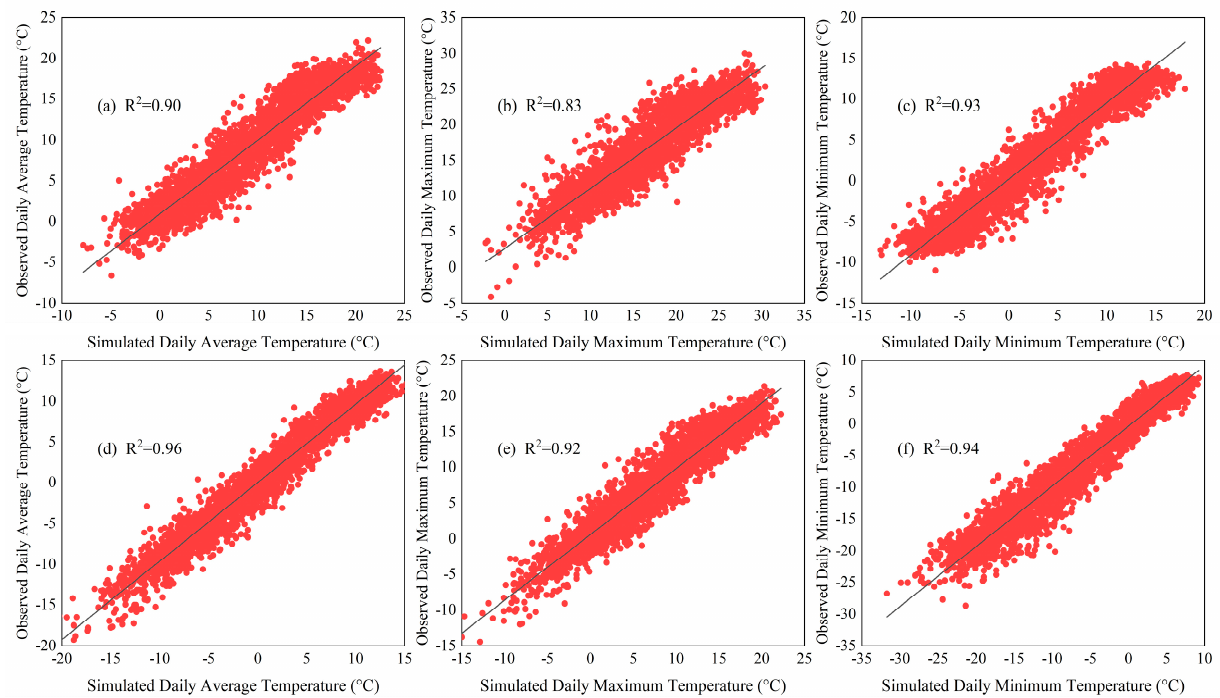
Figure 11. The scatter plots between measured and simulated daily average, maximum, and mini- mum temperature of LASHA station ( a – c ) and NAGQU station ( d – f ). The red line in the figure represents the fitting curve of the scatter.